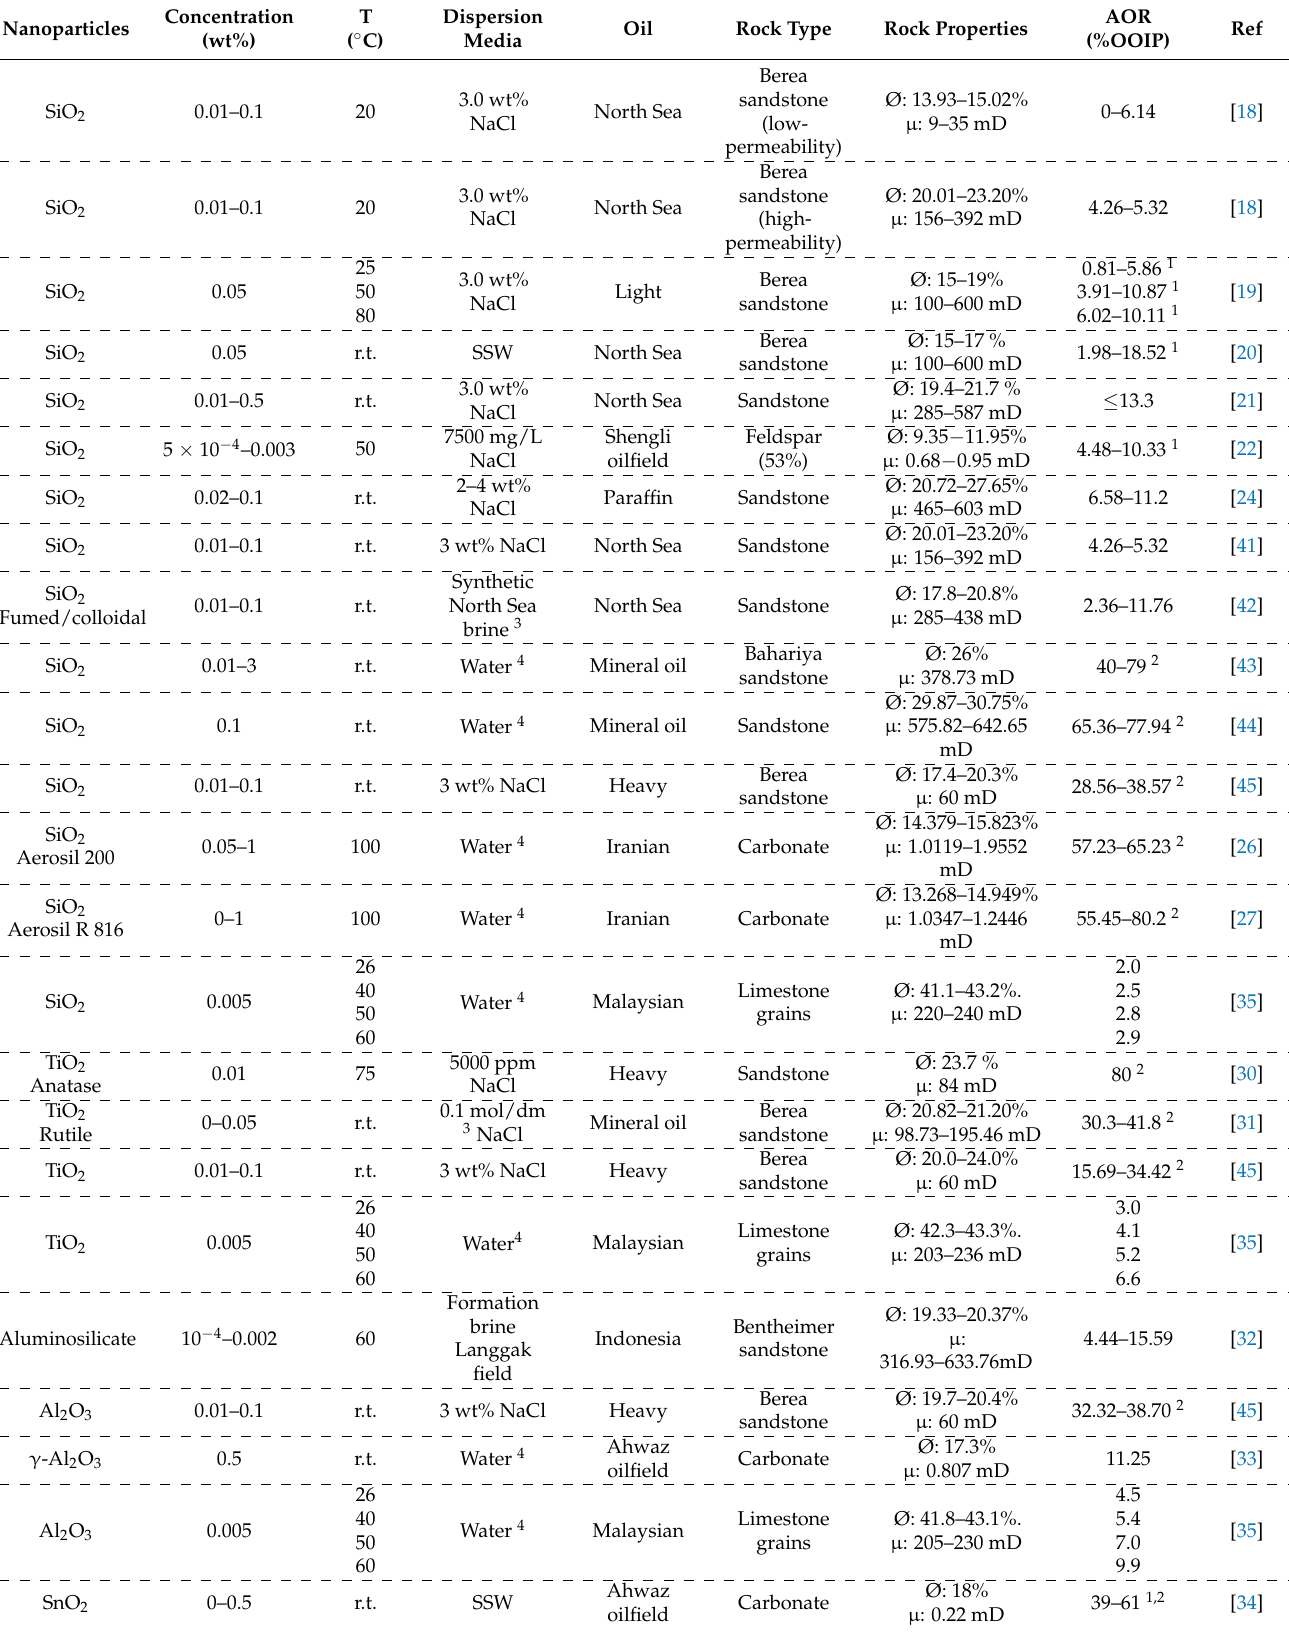
Table 1. Core-flooding tests involving